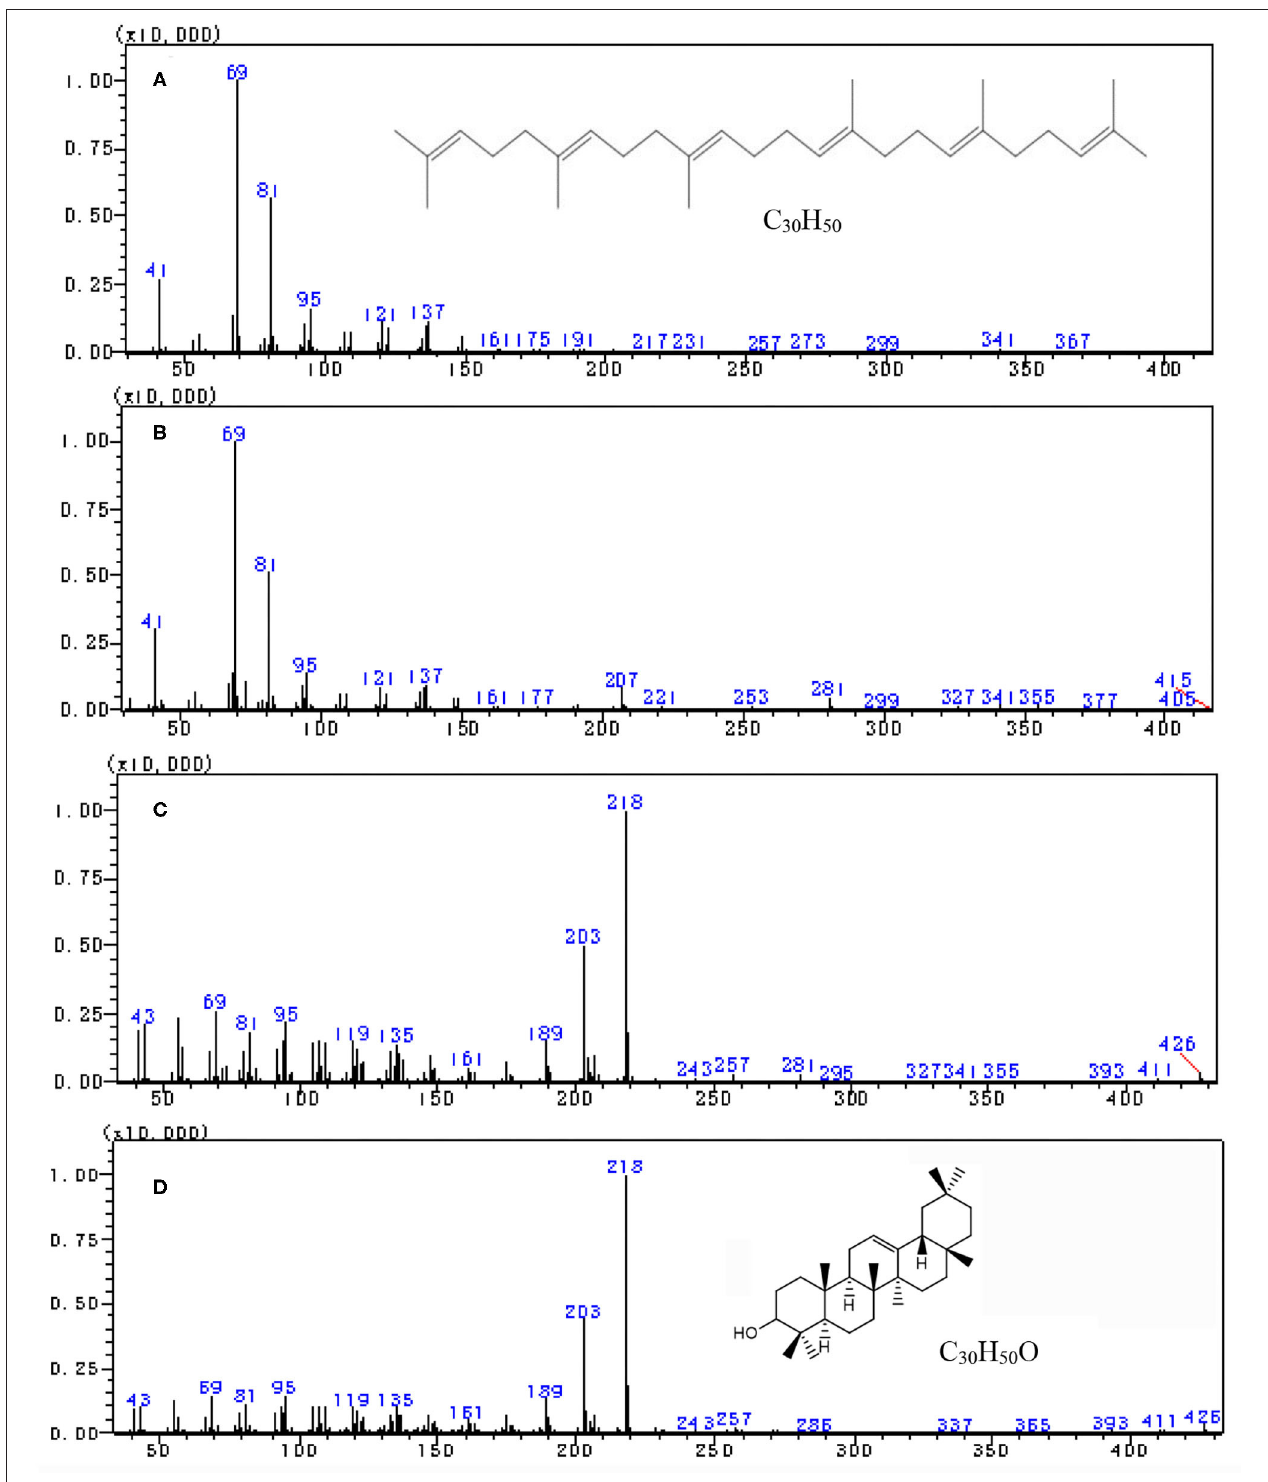
FIGURE 2 | Full scan mass spectra by gas chromatography-mass spectrometry (GC–MS) analysis. (A) Squalene reference, (B) peak 1 in tea extract, (C) peak 2 in Figure 1B , and (D) β -amyrin reference.